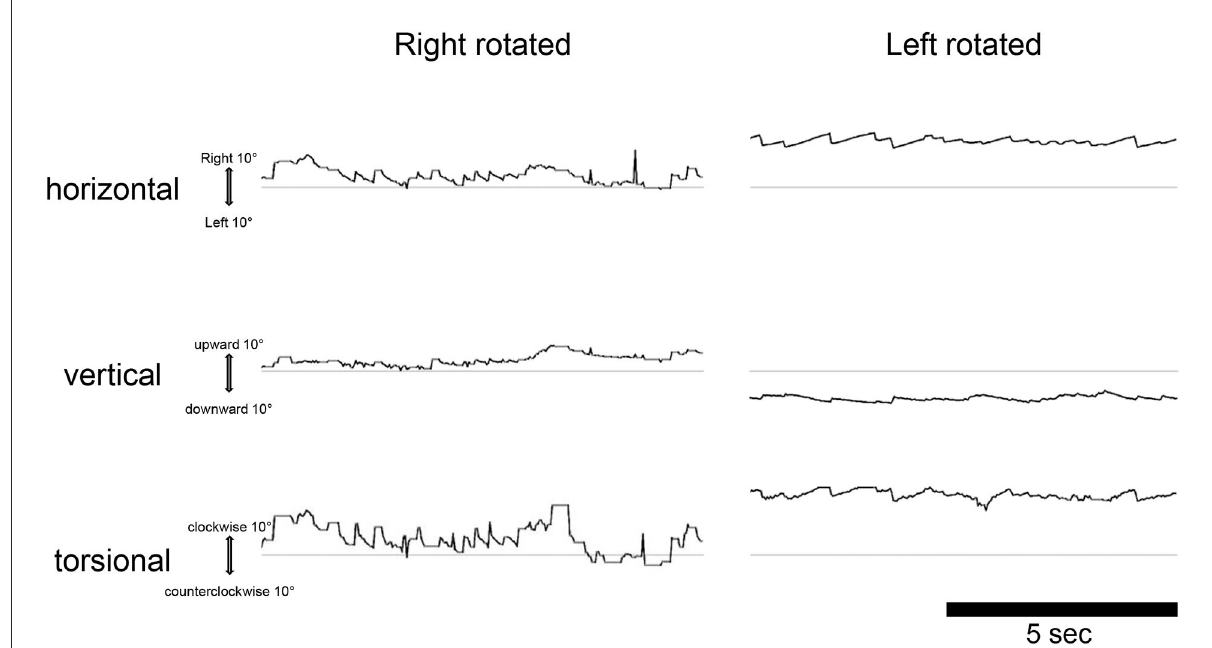
FIGURE4 Video oculography findings in the dark 270min after injection of 17 O-labeled water in the right (affected) tympanic space in a patient with cochlear endolymphatic hydrops. The eye movements are displayed from top to bottom, as horizontal, vertical, and torsional as indicated. The upward direction of each trace indicates right, up, and clockwise (from the subject view). The ordinate and abscissa indicate the eye position in degrees and time in seconds, respectively. The average slow phase speed of nystagmus was 4 ◦ /s to the right, 2 ◦ /s down, and 6 ◦ /s clockwise for the left rotated, and 8 ◦ /s to the left, 3 ◦ /s down, and 19 ◦ /s counterclockwise for the right rotated.